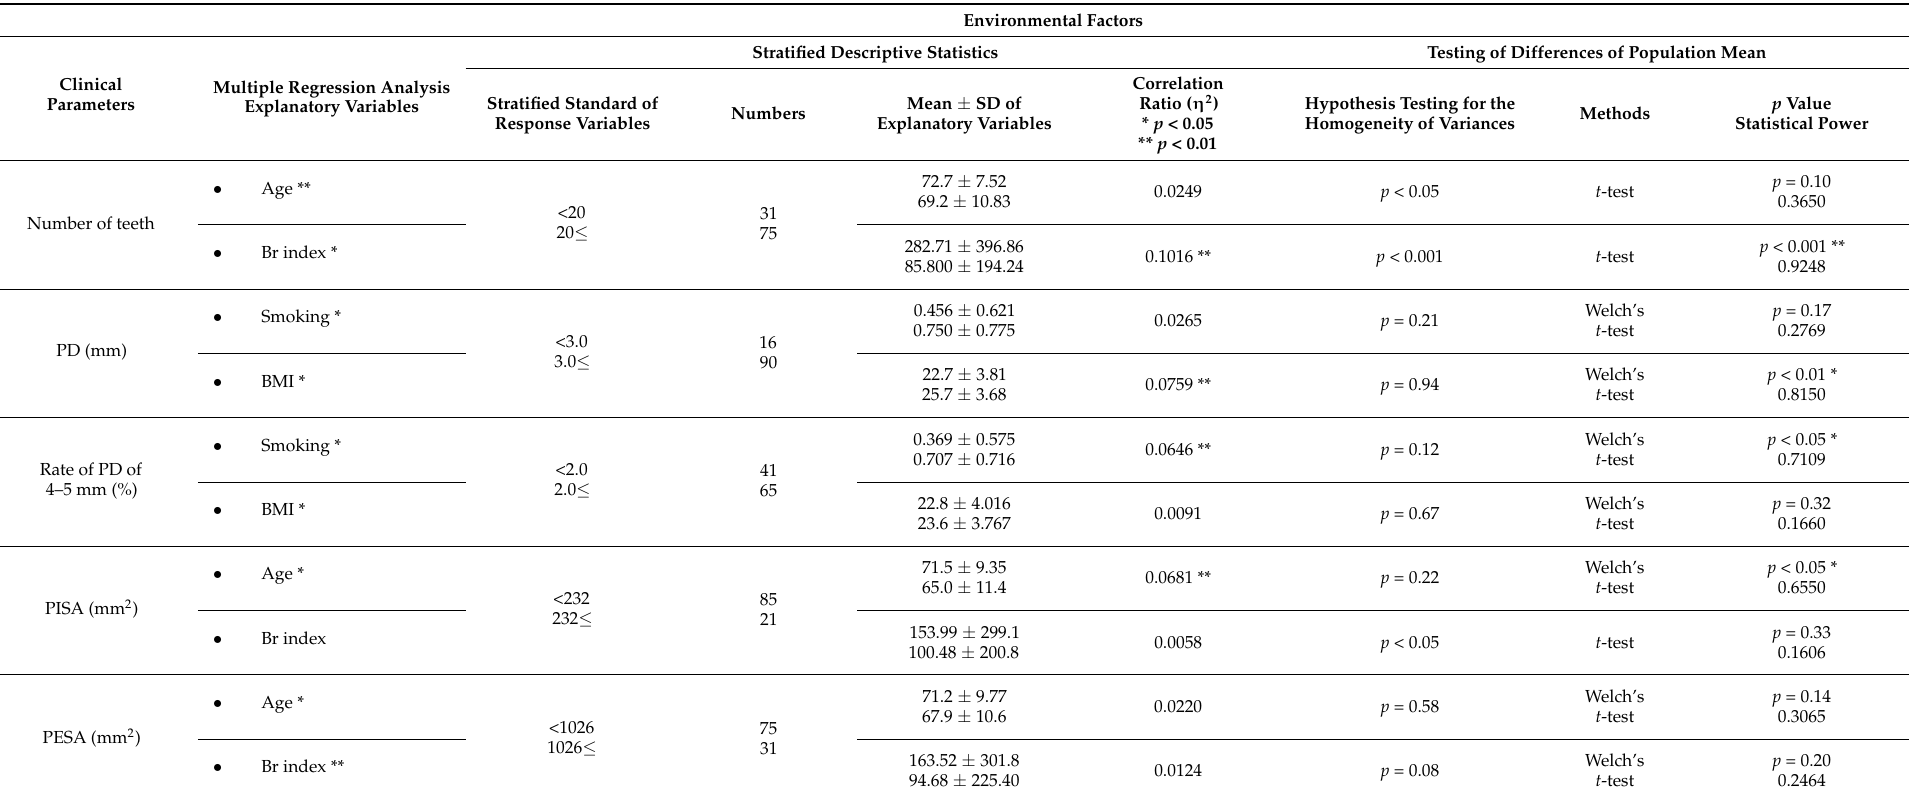
Table 3. Stratified descriptive statistics between clinical parameters and environmental